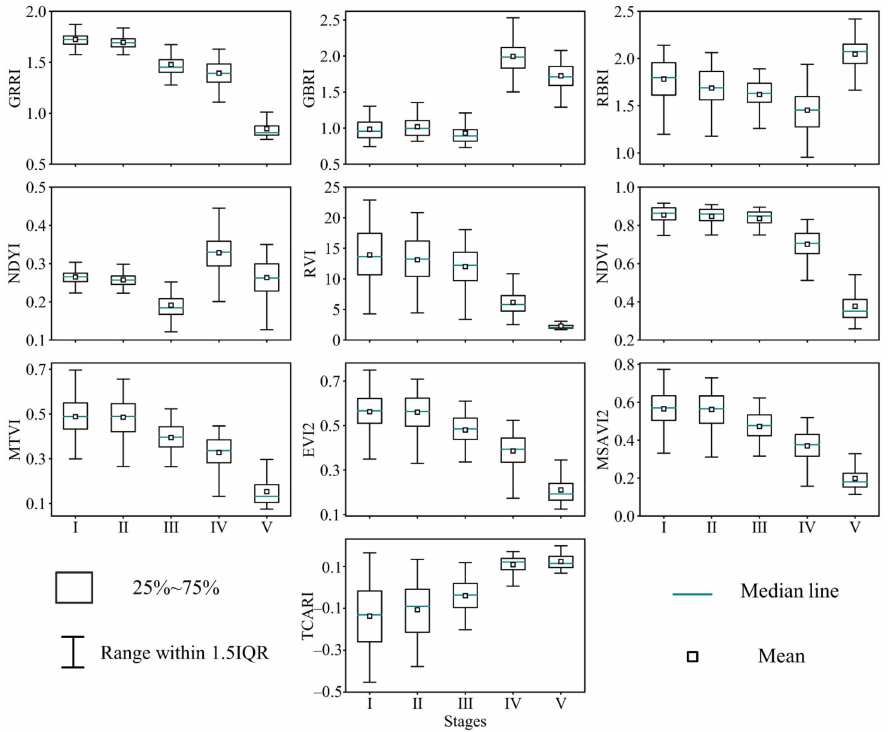
Figure 4. Variation of the vegetation indices (VIs) at five growth stages ( I : jointing stage; II : heading stage; III : flowering stage; IV : filling stage; V : milk-ripe stage). IQR represents the interquartile range of each VI calculated from all the sampling